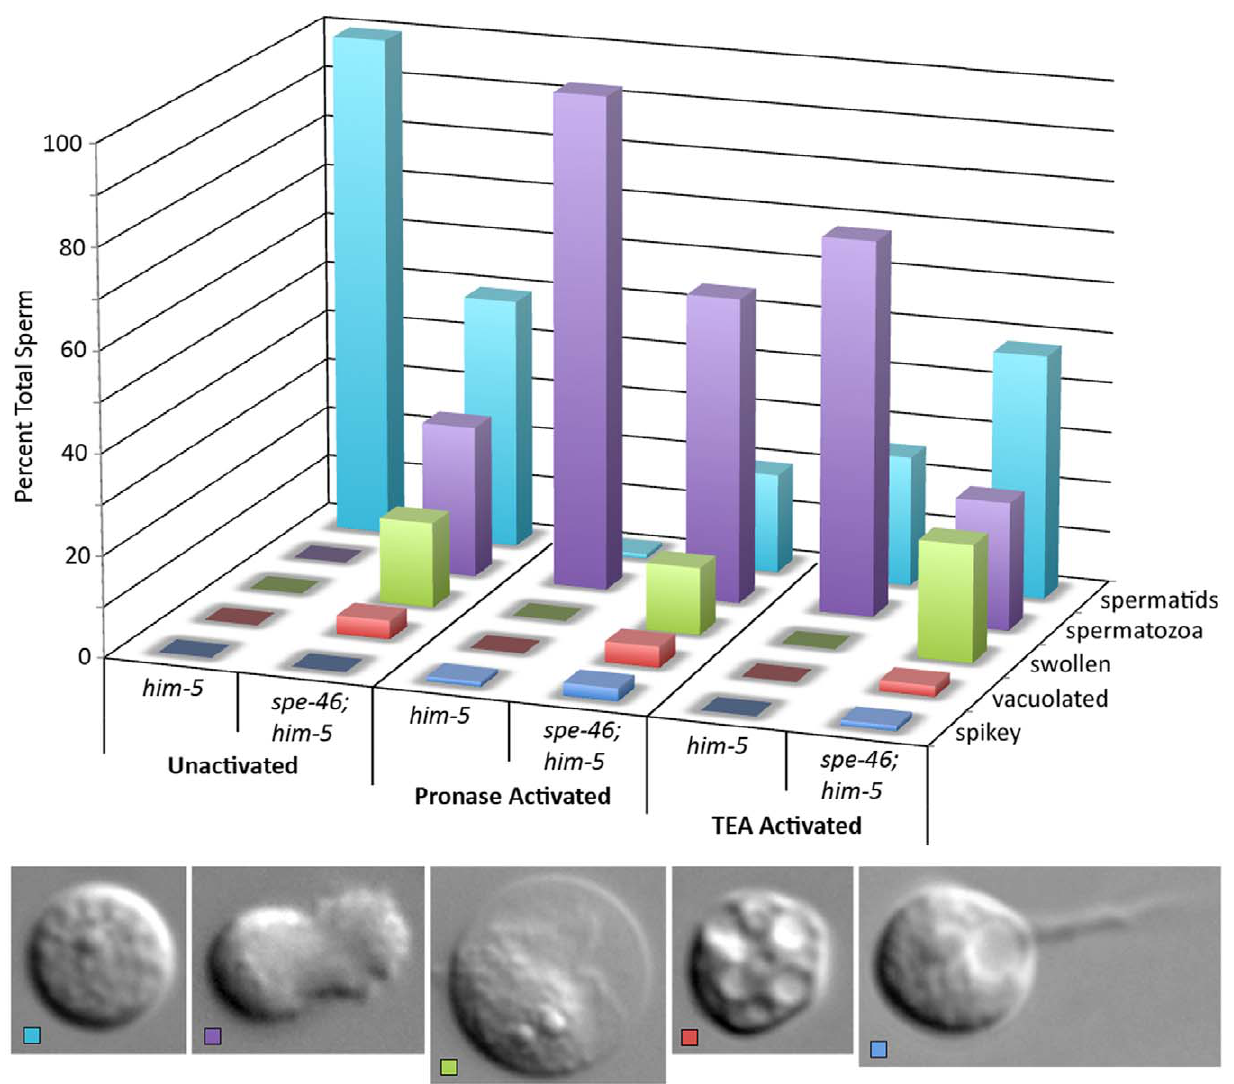
Figure 10. The sperm phenotypes from spe-46(hc197);him-5(e1490) males. Males were dissected in SM1 buffer (unactivated), in SM1 plus Pronase (200 m g/ml) (pronase activated), and in SM1 plus 70 mM Triethanolamine (TEA) (TEA activated). Sperm phenotypes are categorized into: (i) spermatid (blue), (ii) spermatozoa (purple), (iii) sperm that appeared swollen (green), (iv) sperm that had large vacuoles (red), and (v) sperm with extended spikes (blue). The number is expressed as percent total sperm. DIC image of sperm phenotypes are shown at the bottom of the graph. Scale bar is 5 m m.